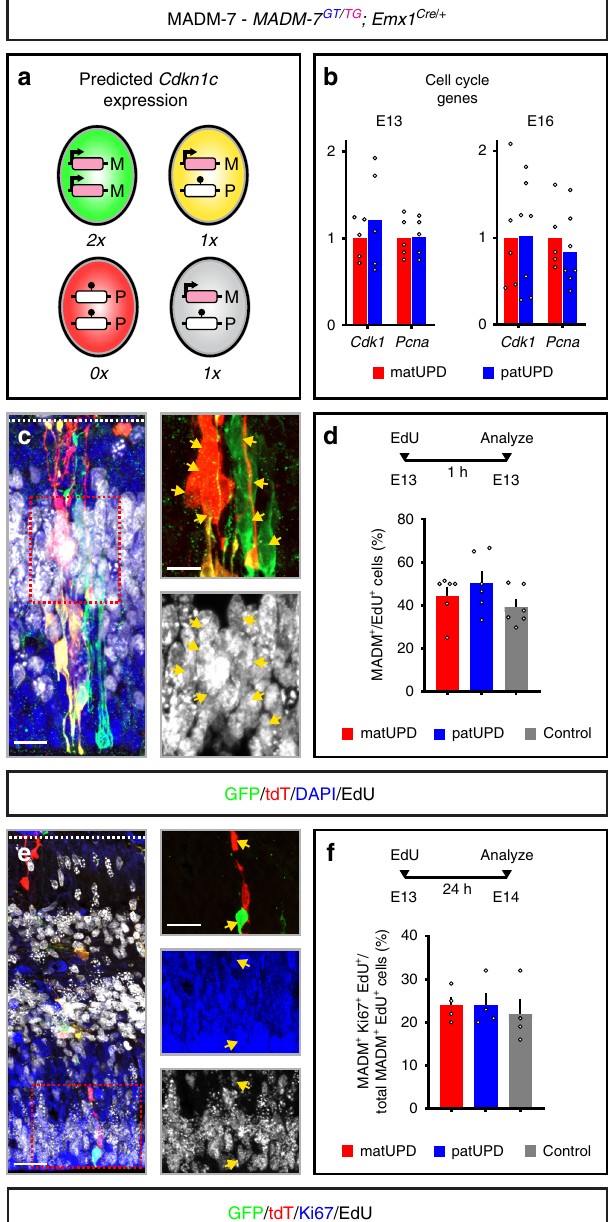
E12 to con fi rm the presence of respective SNPs in Cdkn1c and Ndn . Sanger and deep sequencing of the genomic DNA con- fi rmed the presence and ~50% abundance of each parental SNP as expected (Supplementary Fig. 5b – h, o). Next, we generated